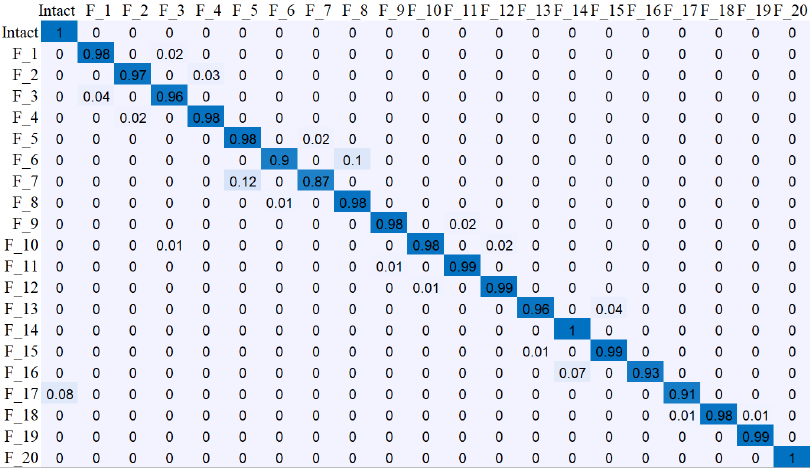
Figure 16. Failure detected location when there are 7 sensors at points 2, 3, 4, 5, 6, 7, and 8 (Accuracy: 98.1%). Table 5. Failure-detection accuracy at different sensor combinations. Sensor Location 2, 5, 8